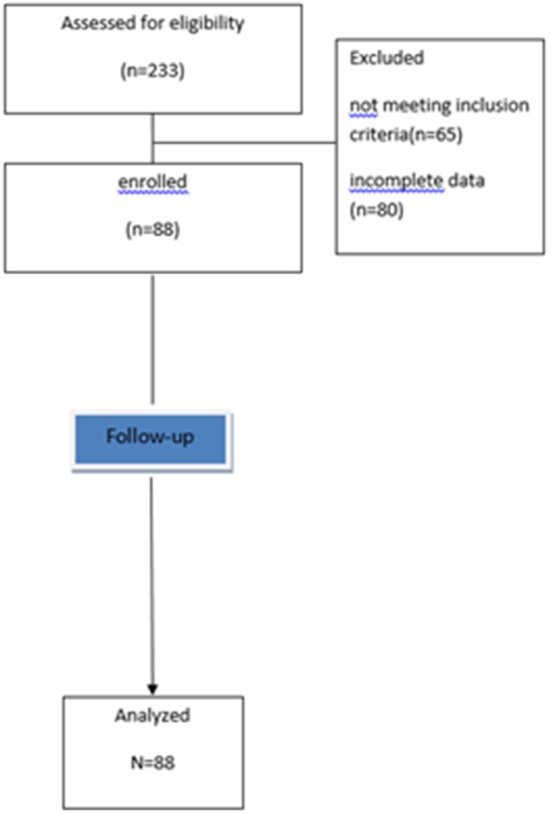
Study flow-chart.